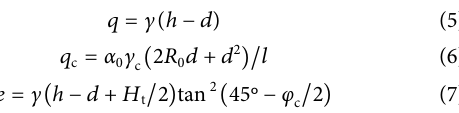
FIGURE 3 Geometric model of covered arch for shallow-buried section of mountain tunnel f (cid:1) f 0